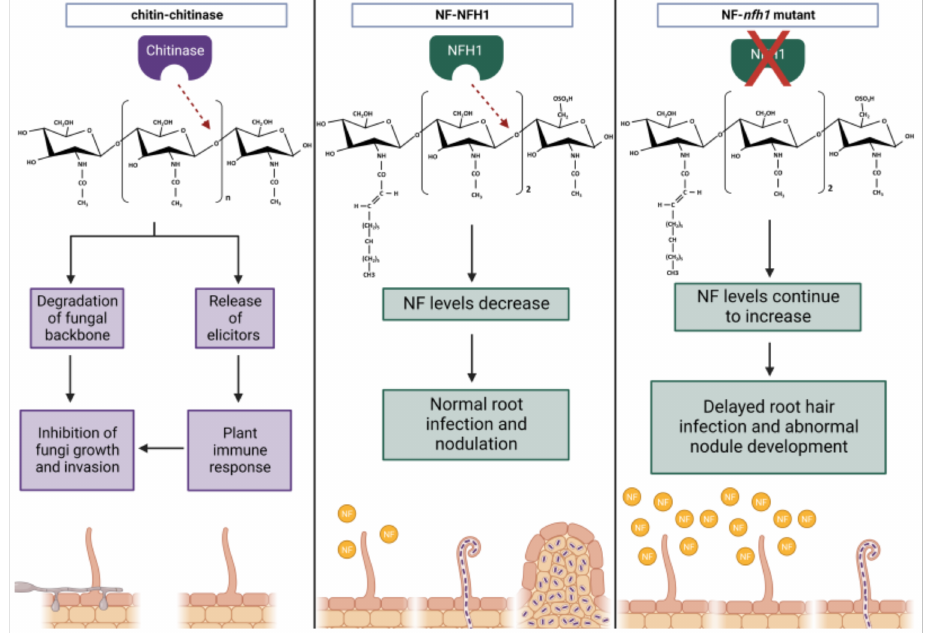
Figure 2. A comparison of the proposed roles of chitinases targeting the glycosidic linkages in either chitin or NFs for degradation. In response to a phytopathogenic fungi, the plant releases chitinases, which function to degrade the chitin backbone and/or release elicitors to further upregulate defences. In response to NFs, chitinase NOD FACTOR HYDROLASE1 (NFH1) degrades NFs to regulate NF levels and optimise root hair infection. In the absence of NFH1, NF levels are unregulated, which results in delayed root-hair infection and abnormal nodule development. NF—Nod Factor and NFH1—NOD FACTOR HYDROLASE1. Created with